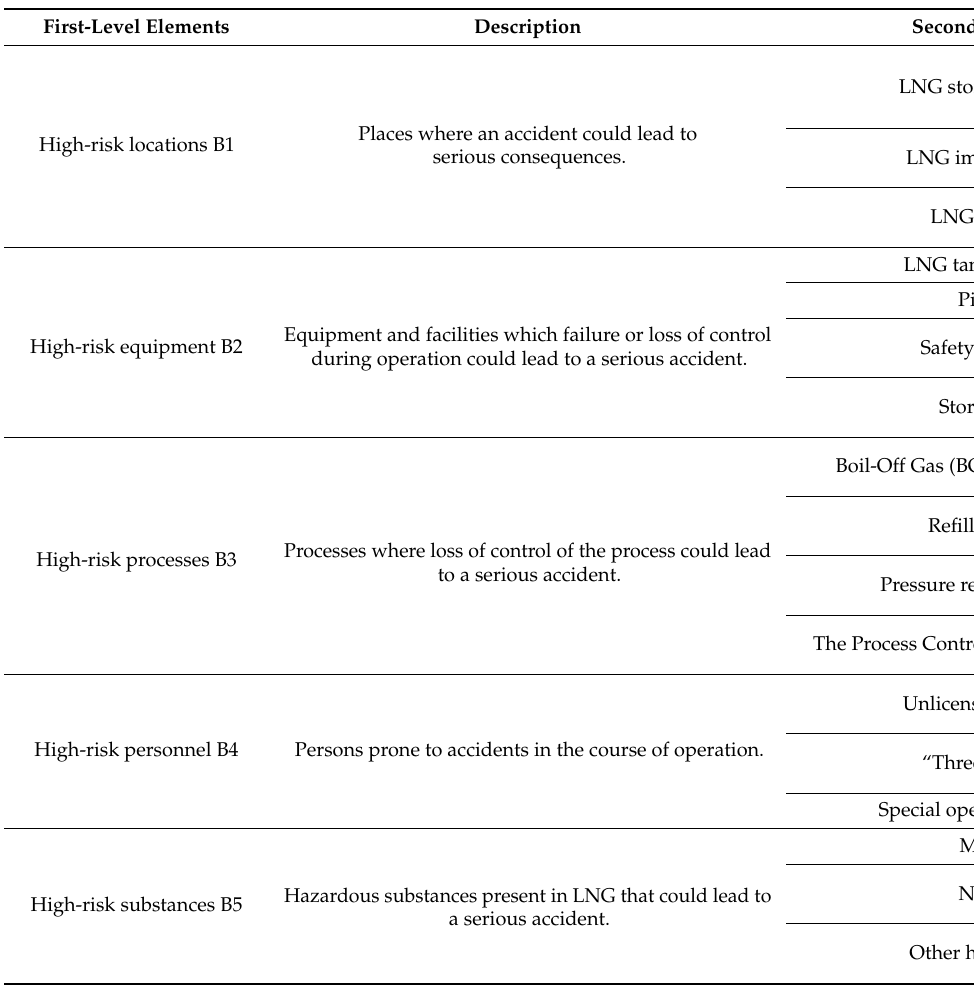
Table 1. Risk element indicators and